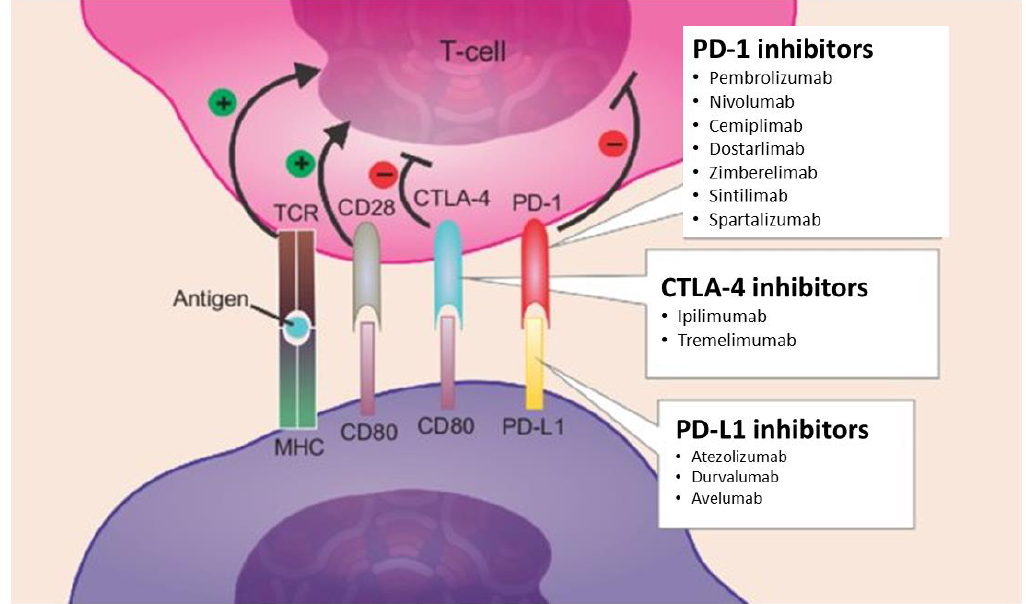
Figure 2. Mechanism of action of immune checkpoint inhibitors. Notes: T regs depend on the activity of CTLA-4, PD-1, and PD-L1 to induce immunosuppression. Ipilimumab and tremelimumab are mon-